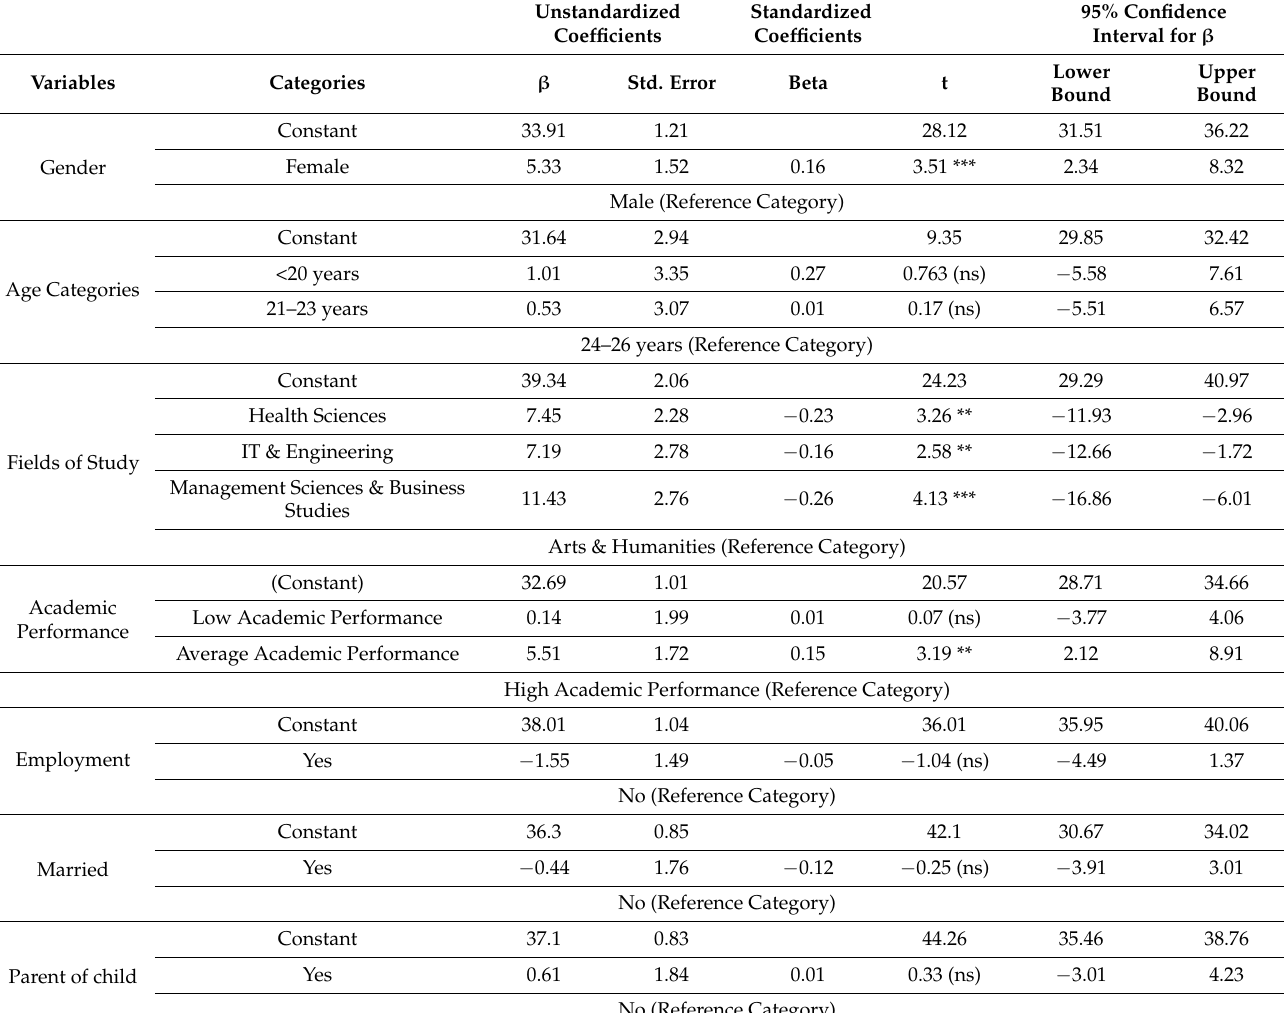
Table 3. Demographic and educational characteristics associated with the poor emotional well-being of students on extended e-learning in Saudi Arabia during the COVID-19 pandemic (N = 434). Unstandardized